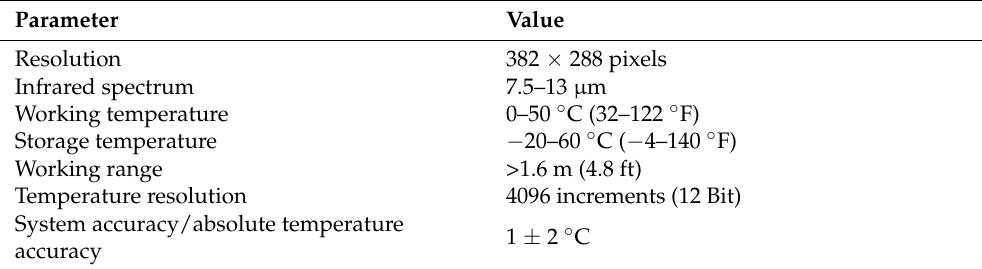
Table 1. Technical data of the thermal infrared camera used in this paper.